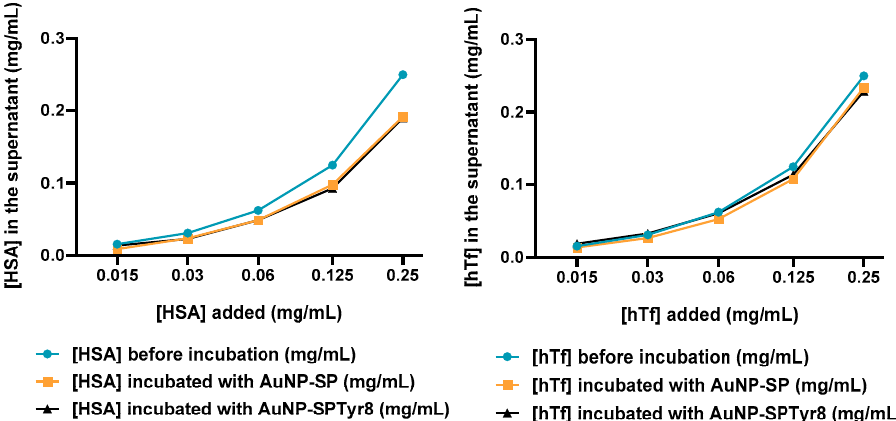
Figure 2. Variation of the concentrations of HSA ( left ) and hTf ( right ) proteins in the supernatant solutions, before and after incubation with AuNP-SP and AuNP-SPTyr8 used at a 0.1 mg/mL concentration, as determined by CD spectroscopy.